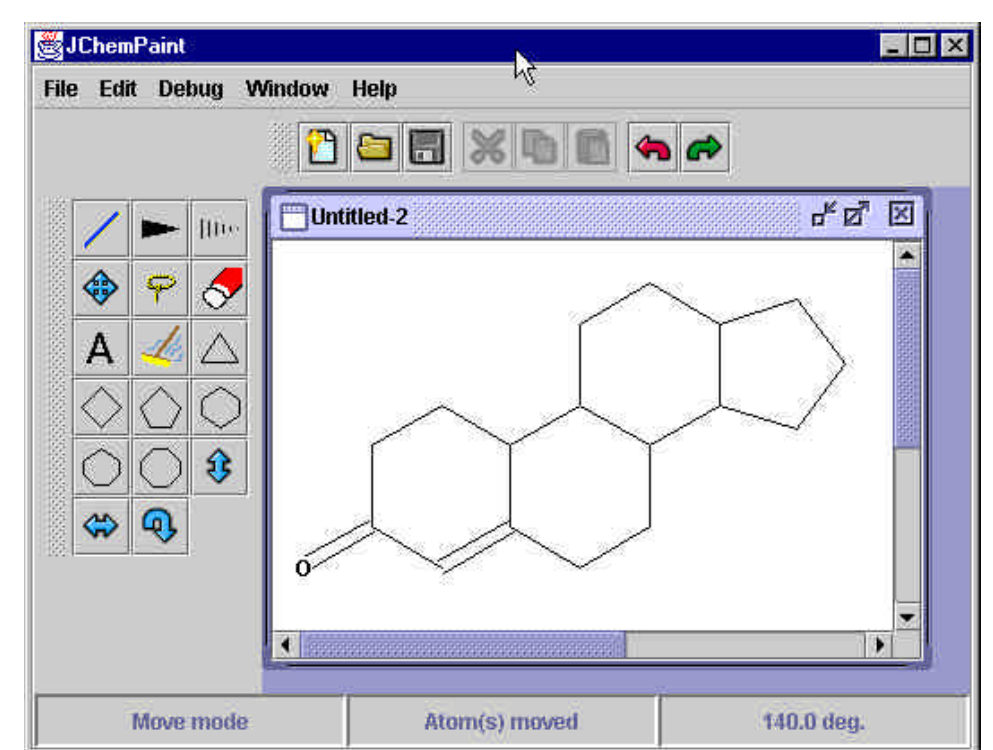
Figure 1. A screenshot of JChemPaint at